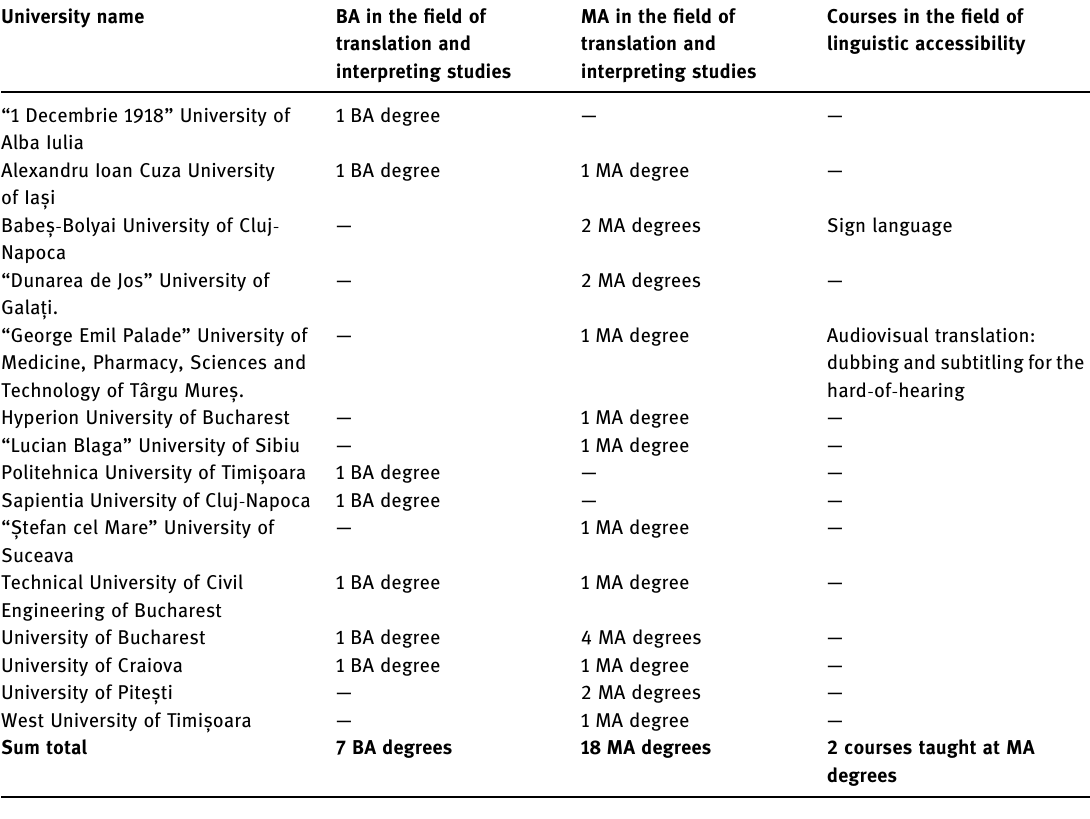
Table 2: BA and MA degrees in the fi eld of translation and interpreting studies in Romania and the course o ff er in the fi eld of linguistic accessibility